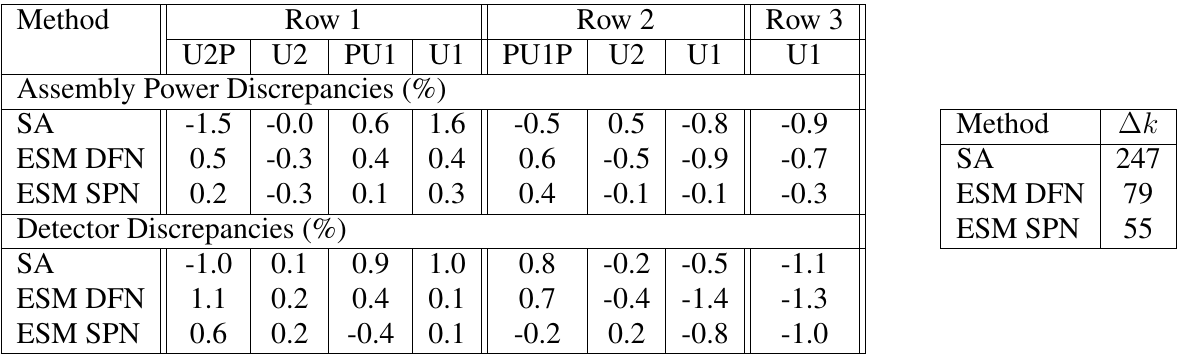
Table II: Power and detector comparisons and k eff differences versus WIMS-CACTUS for the KAIST quarter